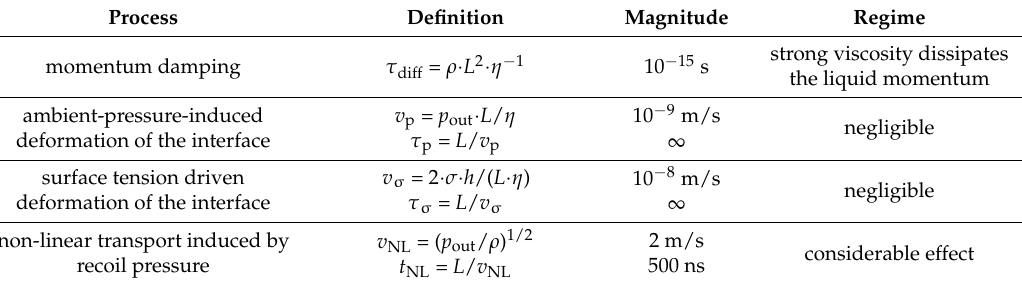
Table 1. Non-dimensional number analysis of the hydrodynamic phenomena in the laser-induced molten layer of fused silica. This interpretation was constructed using Ref. [53] with L : Typical size of the system, h : Molten layer thickness, τ : Relaxation time, v : Velocity, ρ : Volumic mass, η : Dynamical viscosity, σ : Surface tension, c : Heat capacity, κ : Thermal conductivity, p : Pressure, and g : Gravitational